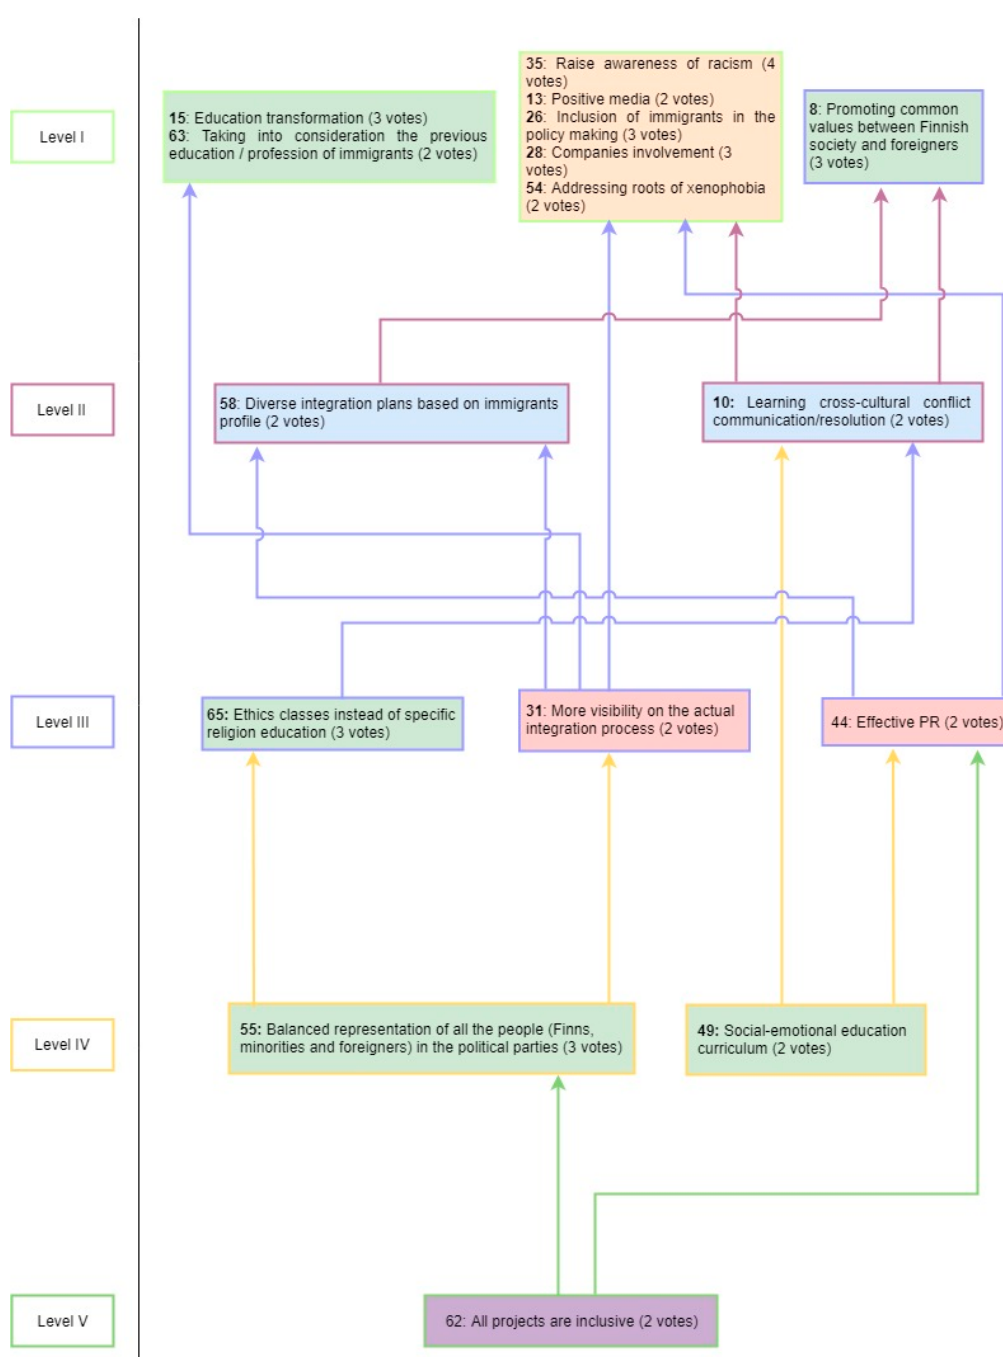
Figure 5. Final influence map produced by the participants.